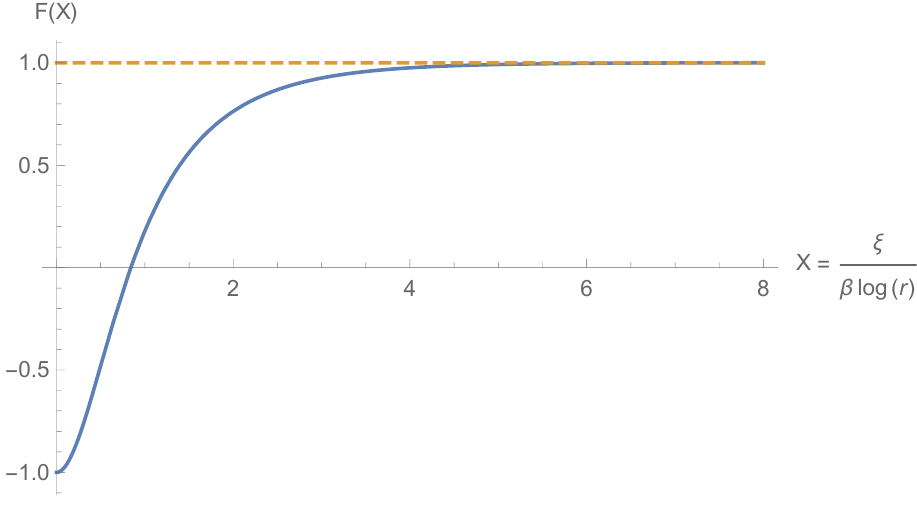
Figure 2 . Numerical solution to (G.36) with the boundary conditions of